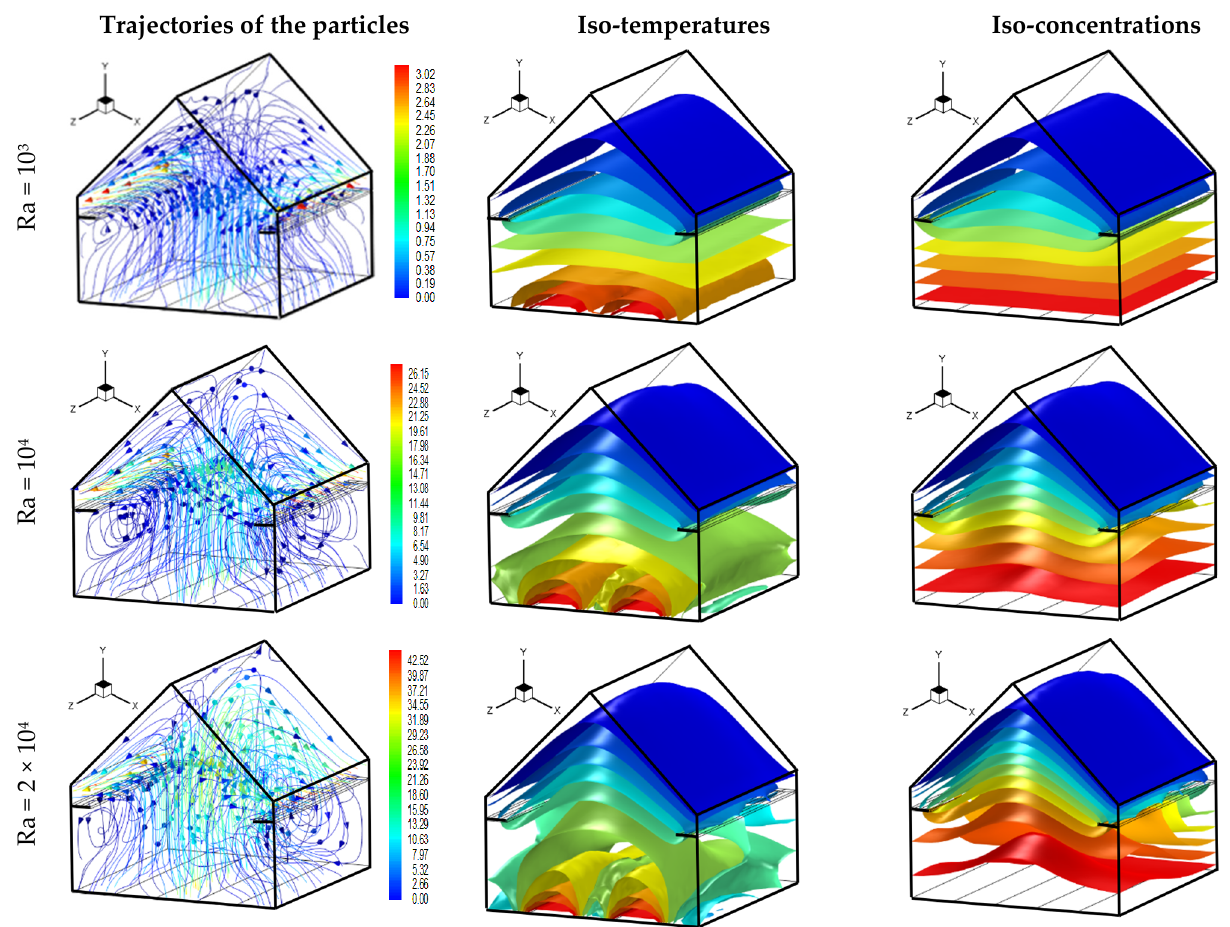
Figure 4. Particle trajectories, iso-surfaces of temperature and concentration for N = 0 and θ = 0° (case 0) .